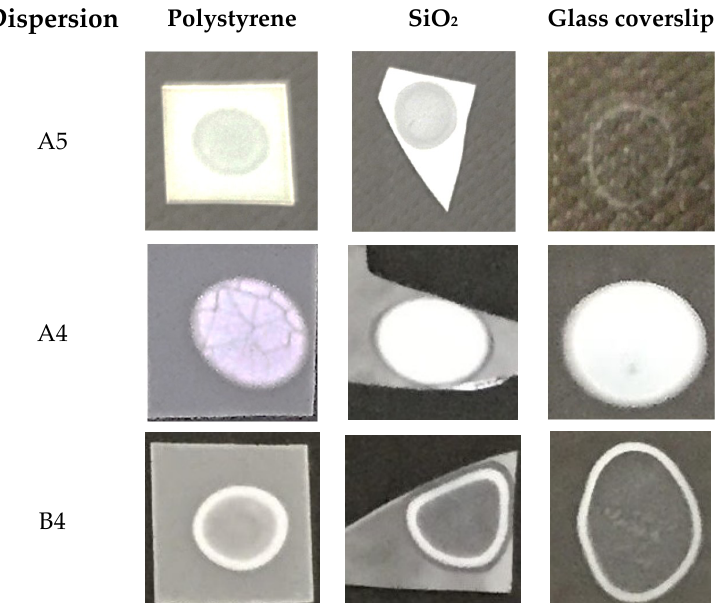
Figure 2. PMMA/PDDA films casted from 50 µ L droplets of A5 (4.4 mg/mL), A4 (10 mg/mL), and B4 (5.8 mg/mL) dispersions on polystyrene sheets, silicon wafers, or glass coverslips.